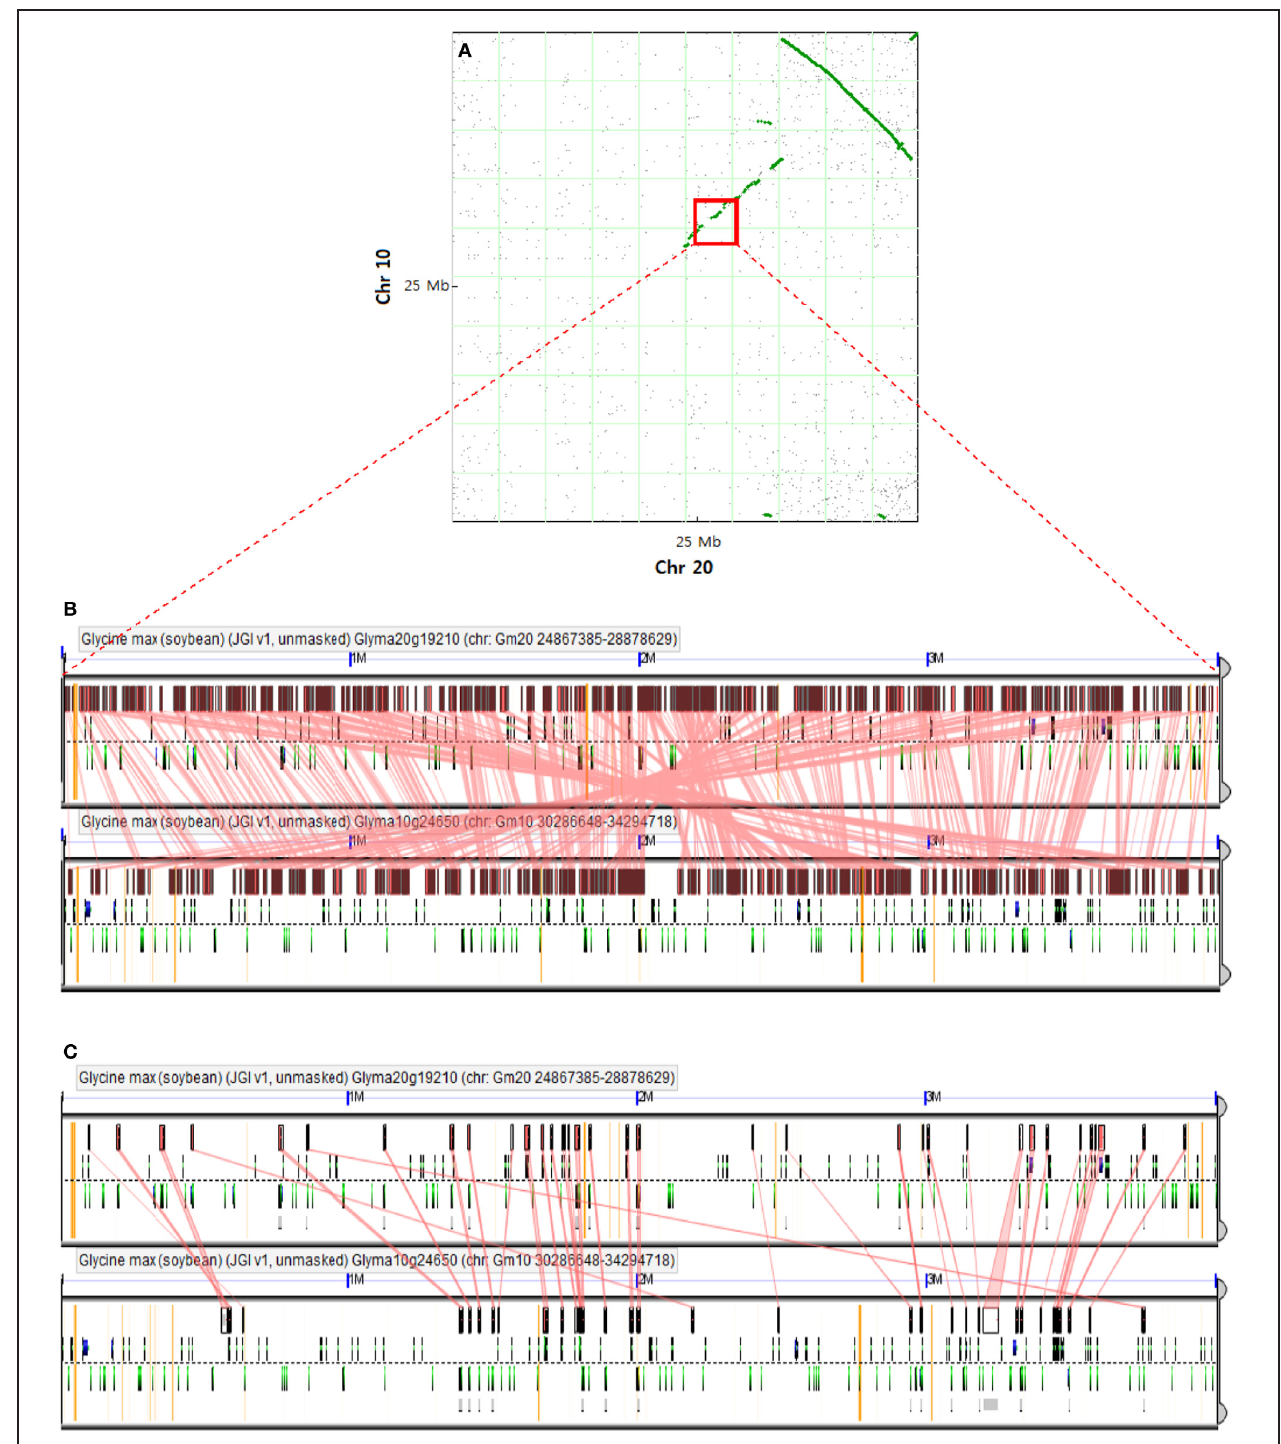
FIGURE 2 | Comparison of two soybean chromosomes. (A) Syntenic dot plot of soybean Chr 10 and Chr 20 [adapted from Cannon and Shoemaker (2012)]. Each dot represents homology of the predicted synteny between two chromosomes. A large inversion of synteny in the upper right quadrant is indicated by a line of homology dots that slope down to the right. A positive correlation based on synteny between two chromosomes is denoted by a discontinuous line with a slope moving up to the right. Red square denotes a